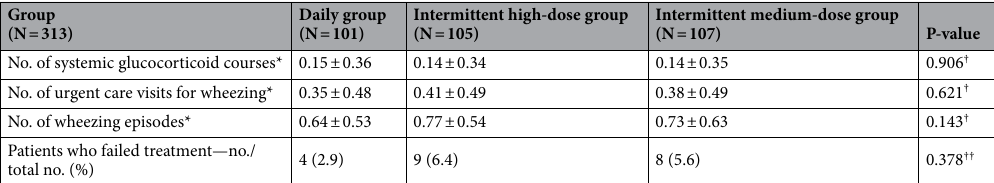
Table 3. Secondary outcomes after treatment. *Plus–minus values are means ± SD. † Kruskal–Wallis test. †† Chi-square